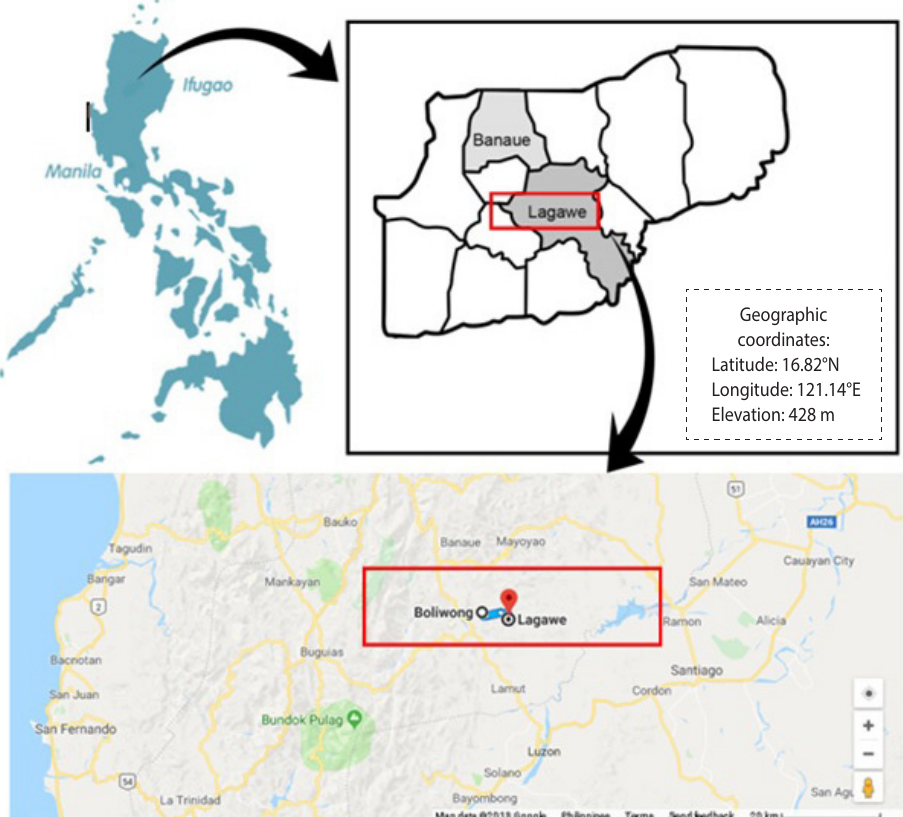
Figure 1. Map of Boliwong in Lagawe,